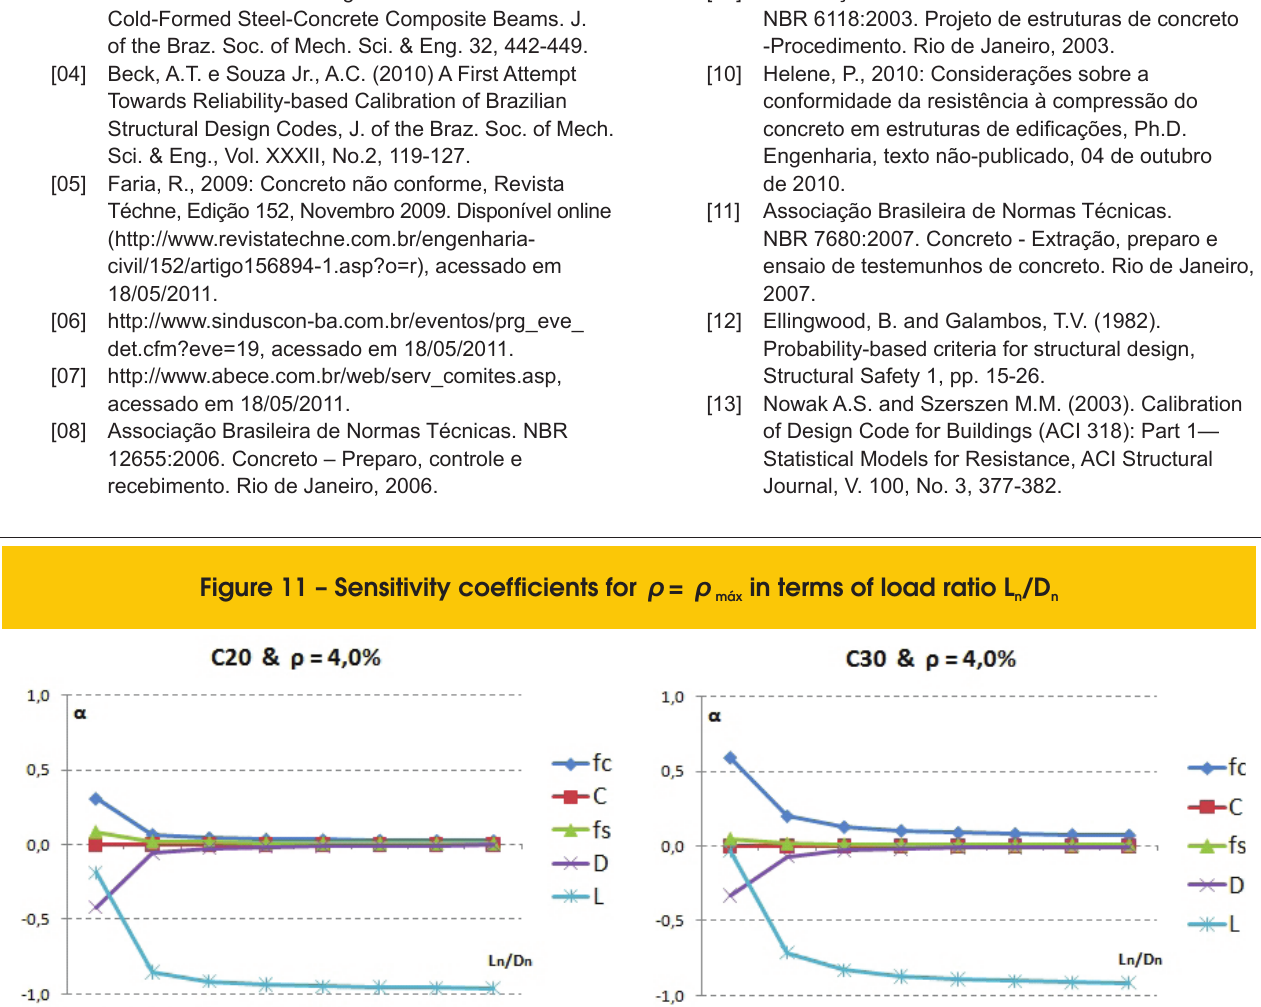
b) Results for C30 concretea) Results for C20